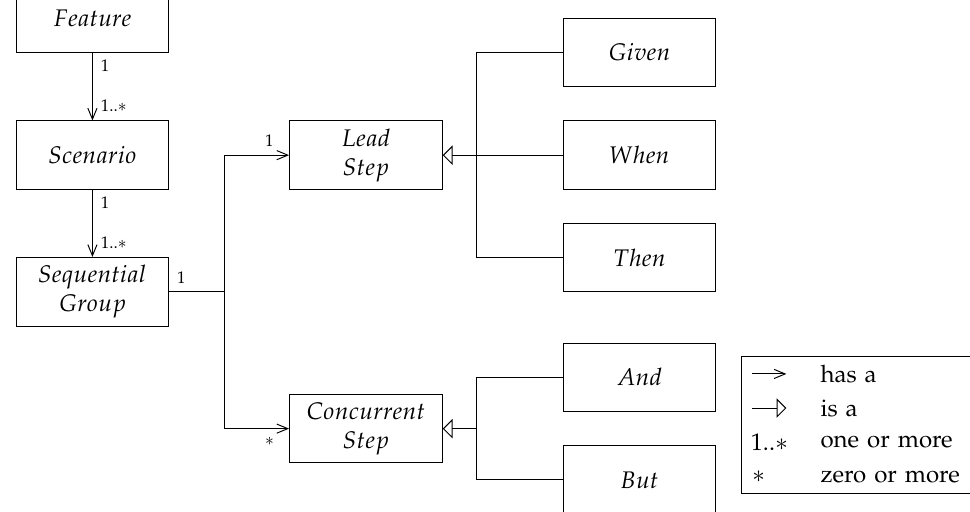
Figure 4. The proposed enhancement to Gherkin for specifying both sequential and concurrent